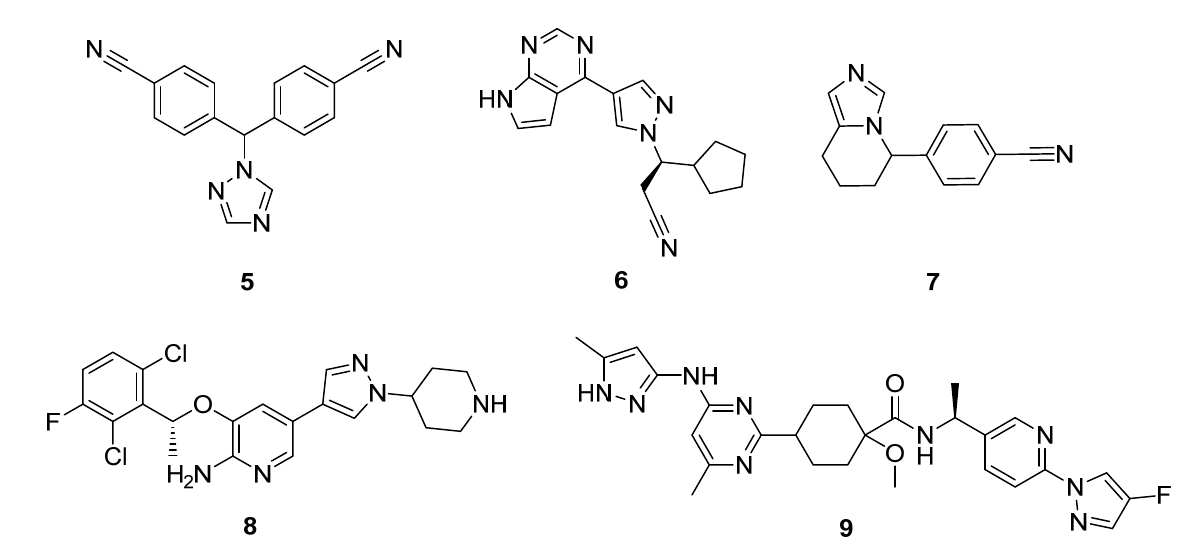
Figure 2. Chemical structures of anticancer drugs with an azole moiety: letrozole ( 5 ), ruxolitinib ( 6 ), fadrozole ( 7 ), crizotinib ( 8 ), and pralsetinib ( 9 ).